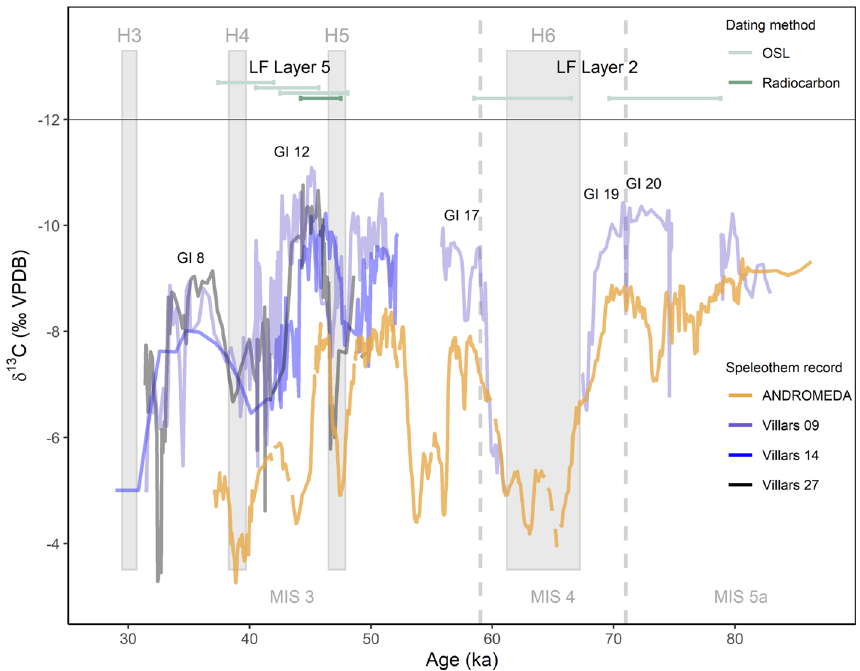
Figure 3. Speleothem records (bottom) from Villars cave 3 and Ejulve cave (ANDROMEDA speleothem; 4) show substantial millennial scale climate variability in both MIS 4 and MIS 3. Given the age ranges (top) 27 and the warm temperatures of site occupation obtained for La Ferrassie Layer 2 suggest that site activity in MIS 4/ late 5a may be attributed to one or several MIS 4 ephemeral warm phases. La Ferrassie Layer 5 likely falls into a warm episode in MIS 3 possibly around Greenland Interstadial 12 (but note an age inversion in the 14 C dates of Layer 5 and Layer 4 as discussed in Supplementary Text